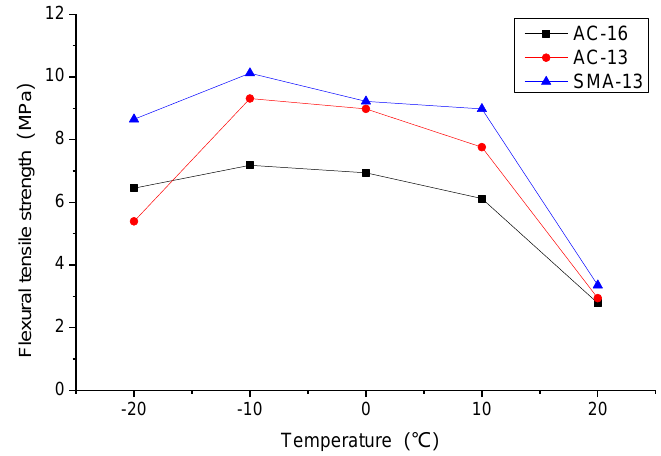
Figure 8. Flexural strength of asphalt mixtures at different test temperatures.